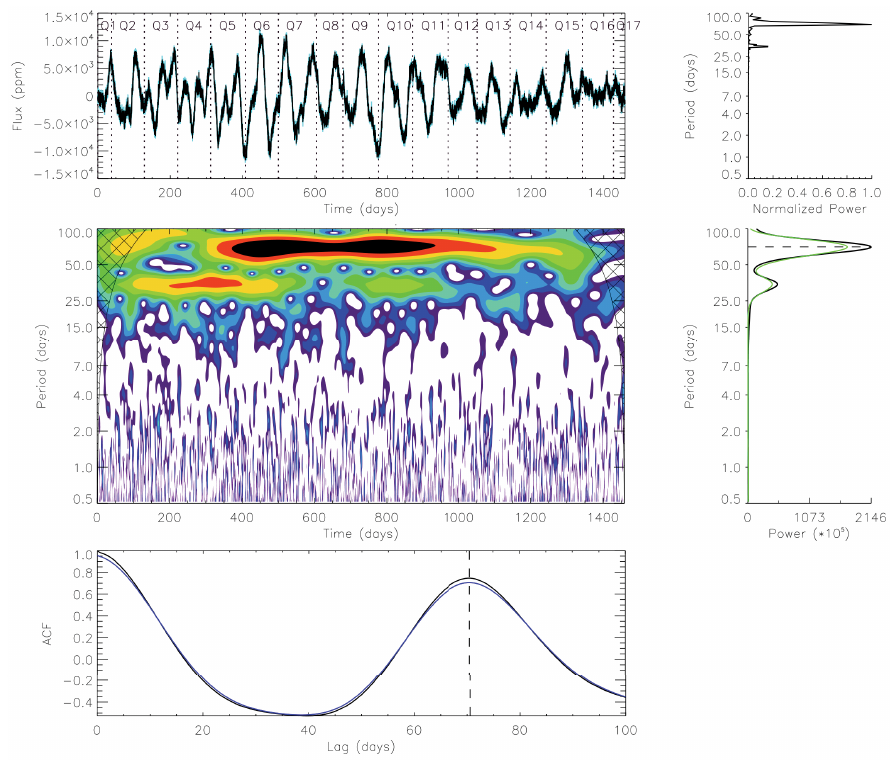
Fig. 1. Example of the analysis for KIC 2570214 (KADAC data). Top panel: Long-cadence Kepler light curve (cyan) and rebinned light curve (black), where vertical dotted lines indicate the transitions between the observing quarters. Top right panel: associated power density spectrum as a function of period between 0.5 and 100 days. Middle left panel: Wavelet Power Spectrum (WPS) computed using a Morlet wavelet between 0.5 and 100 days on a logarithmic scale. The black-crossed area is the cone of influence corresponding to the unreliable results. Middle right panel: Global Wavelet Power Spectrum (GWPS) as a function of the period of the wavelet and the associated fit composed from several gaussian functions (thin green line). The horizontal dashed line designates the position of the retrieved P rot . Bottom panel: AutoCorrelation Function (ACF) of the full light curve plotted between 0 and 100 days (black) and smoothed ACF (blue). The vertical dashed line indicates the returned P rot for the ACF